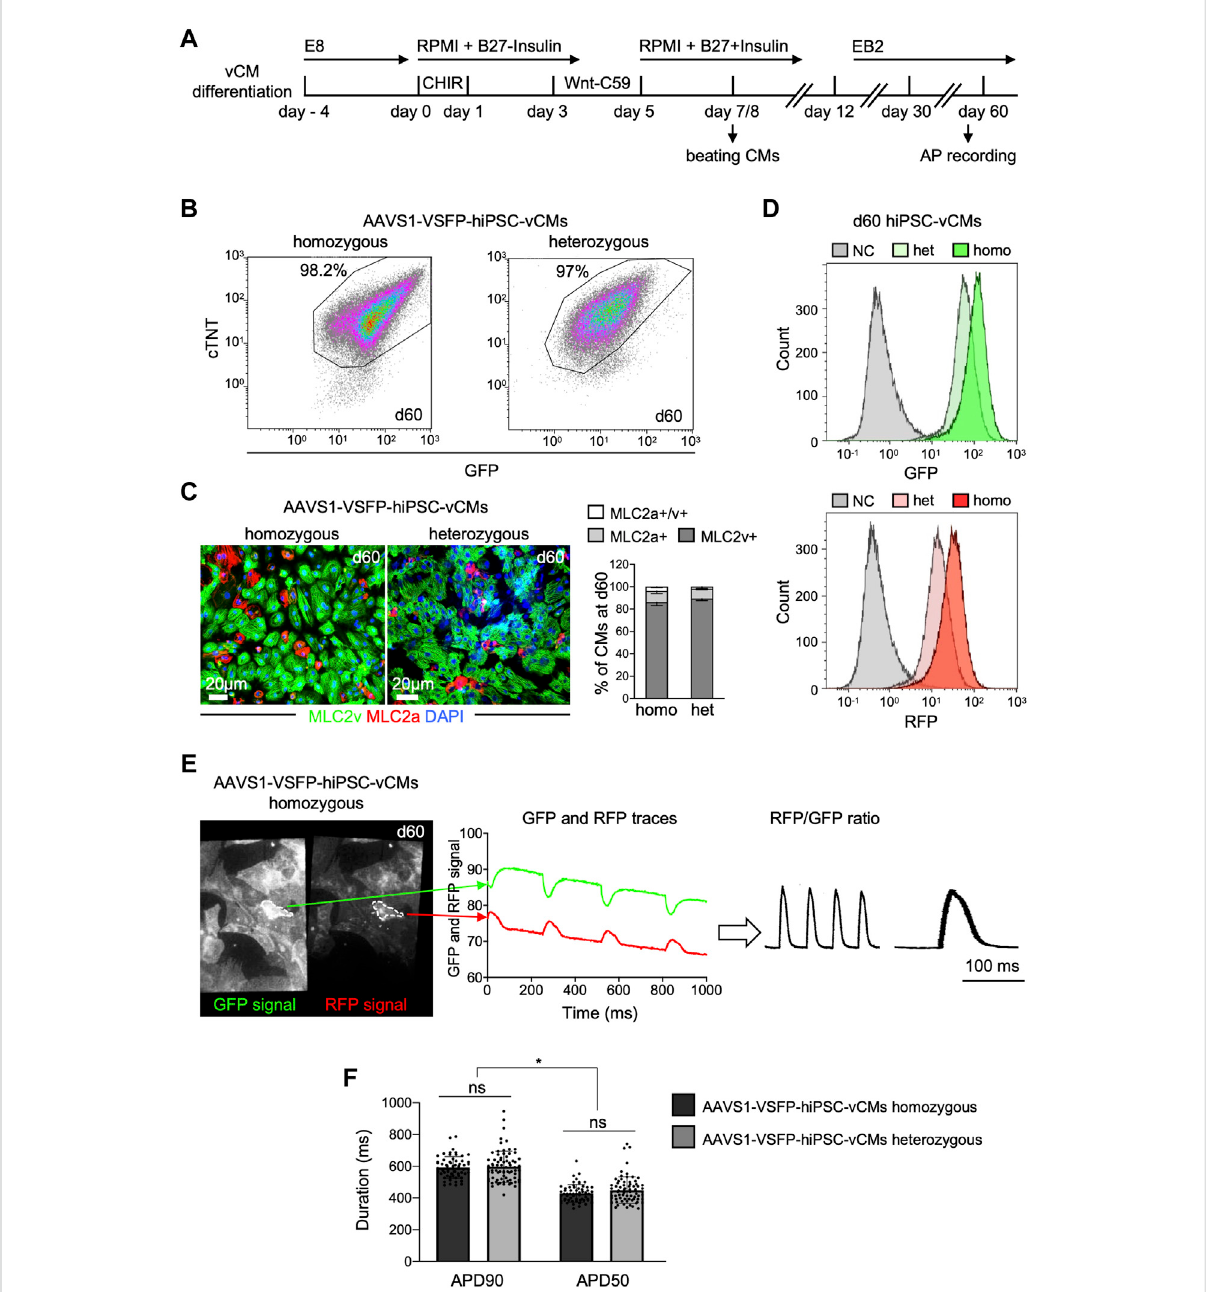
FIGURE 1 Differentiation and optical AP recordings of AAVS1-VSFP-hiPSC-derived ventricular CMs (AAVS1-VSFP-hiPSC-vCMs). (A) Schematic representation of the protocol used for differentiation of hiPSCs into ventricular CMs (vCMs). CHIR: CHIR-98014. (B) Representative fl ow cytometry plots showing d60 (day 60) homozygous and heterozygous AAVS1-VSFP-hiPSC-vCMs immunostained with antibodies against cTNT and GFP. (C) Left panel, representative images of d60 homozygous and heterozygous AAVS1-VSFP-hiPSC-vCMs immunostained with antibodies against MLC2v (green) and MLC2a (red). Nuclei were labeled with DAPI (blue). Right panel, quanti fi cation of MLC2a+, MLC2a+/v+, and MLC2v+ AAVS1- VSFP-hiPSC-vCMs at day 60. Data are mean ± SD; N = 618 homozygous and N = 444 heterozygous AAVS1-VSFP-hiPSC-vCMs from n = 3 differentiations per line. (D) Live cytometry analysis of GFP and RFP expression in d60 hetero- (het) and homozygous (homo) AAVS1-VSFP-hiPSC- vCMs.d60vCMsderivedfromacontrolhiPSClinewereusedasanegativecontrol(NC,gray). (E) SpontaneousopticalAPmeasurementofventricular CMs. Representative GFP and RFP images of d60 homozygous AAVS1-VSFP-hiPSC-vCMs. White dotted lines represent region of interest (ROI) used to quantify the GPF and RFP fl uorescence signal (left panel). Background-corrected GFP and RFP fl uorescence signals derived from the ROI are depicted (middle panel). The APs are calculated as RFP/GFP ratio (right panel). (F) Quanti fi cation of APD90 and APD50 in both homo- and heterozygous AAVS1-VSFP-hiPSC-vCMs at day 60 at spontaneous beating. Data are mean ± SD; N = 61 homozygous and N = 74 heterozygous AAVS1-VSFP-hiPSC-vCMs from n = 3 differentiations per line; * p < 0.0001 (Kruskal-Wallis